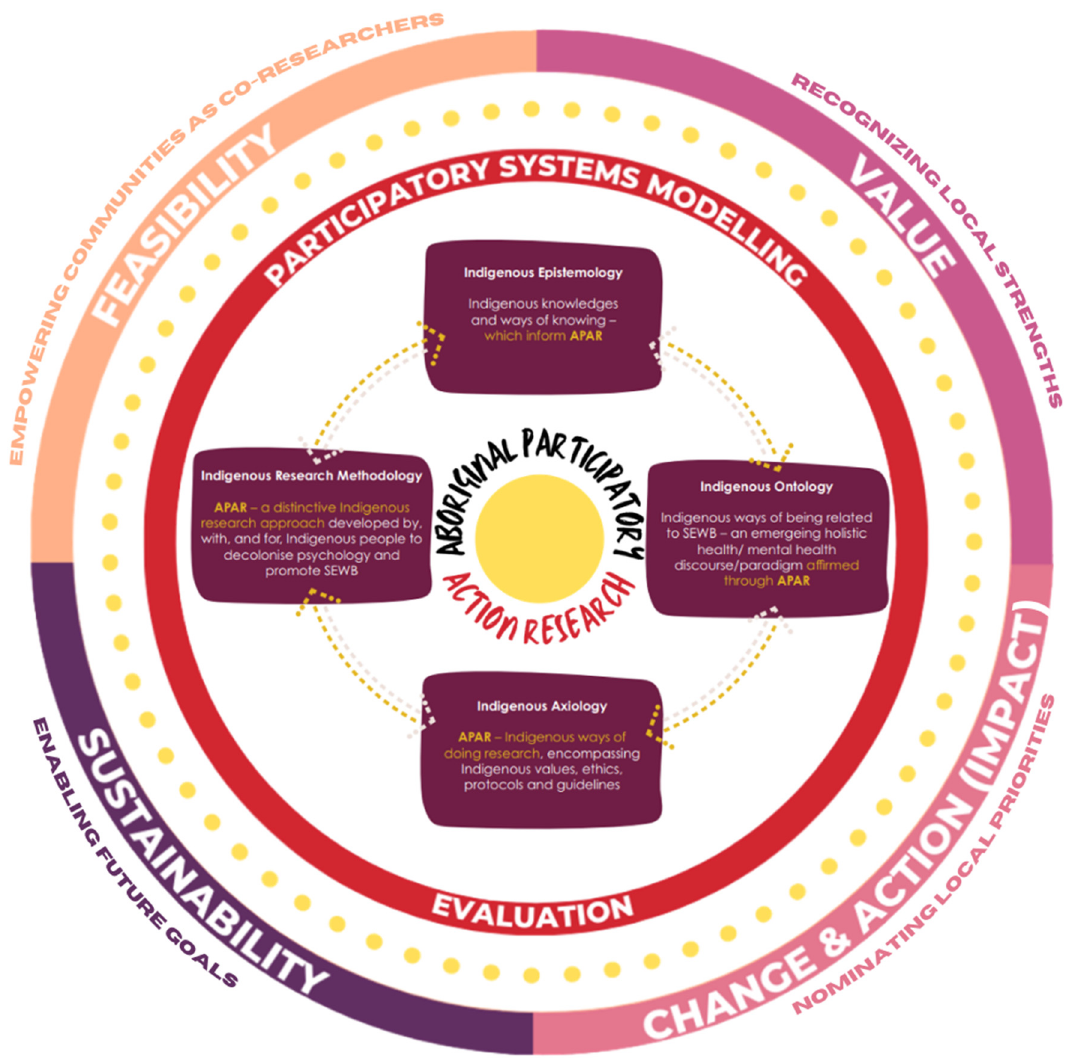
Figure 1. Modified PSM evaluation framework strengthened through APAR elements (i.e., Indige- nous epistemology, ontology, axiology, and methodology). The inner figure depicting the elements of APAR is extracted directly from Dudgeon, Bray, Darlaston-Jones & Walker’s 2020 discussion paper on Aboriginal Participatory Action Research: An Indigenous Research Methodology Strengthening Decolonization and Social and Emotional Wellbeing [56]. The presented modified framework has shared concepts of participatory evaluation which has broader applications including PSM eval- communities.